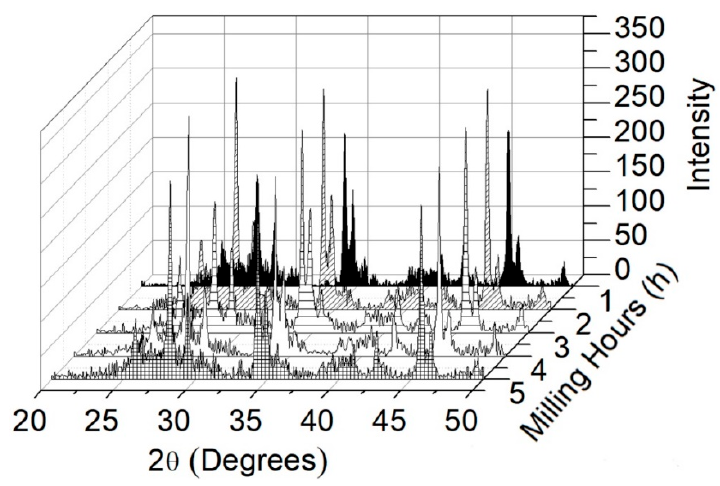
Figure 1. X -ray diffraction (XRD) patterns of MoB 2 specimens at different milling hours.